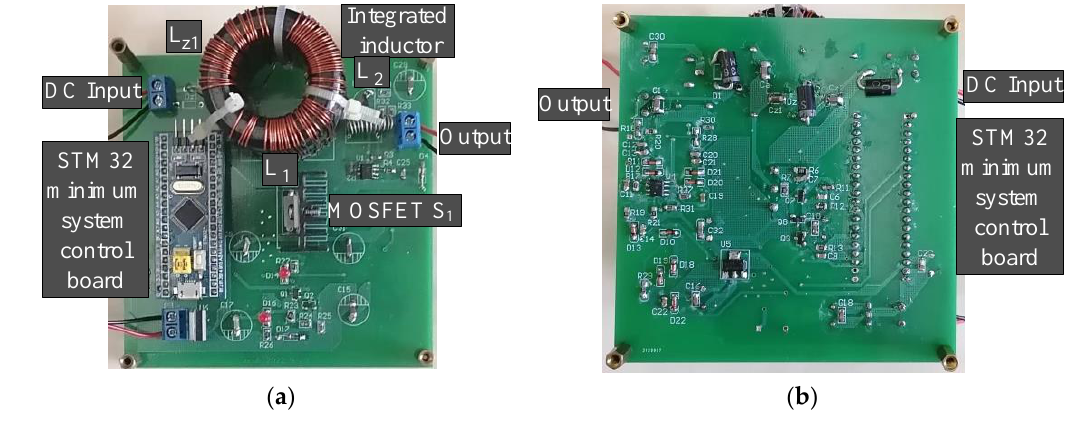
( b ) Figure 10. Simulation waveforms of the DCM operation. ( a ) Light discontinuous operation wave- form; ( b ) deep discontinuous operation waveform.